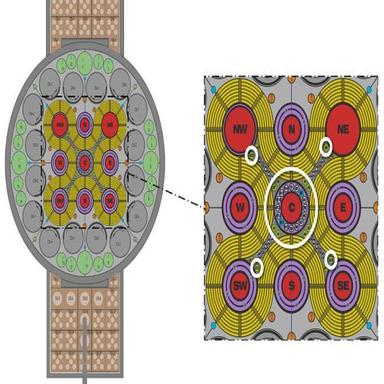
ATR core layout. The positions considered in this paper are the 15.9 mm diameter inner A, large outer A, and H positions (circled in white).